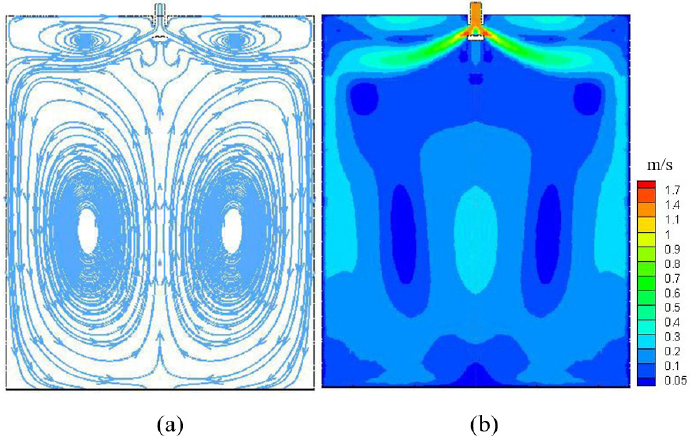
Figure 8. Fluid contours: ( a ) trajectory line; and ( b ) flow field at a thickness of 220 mm.